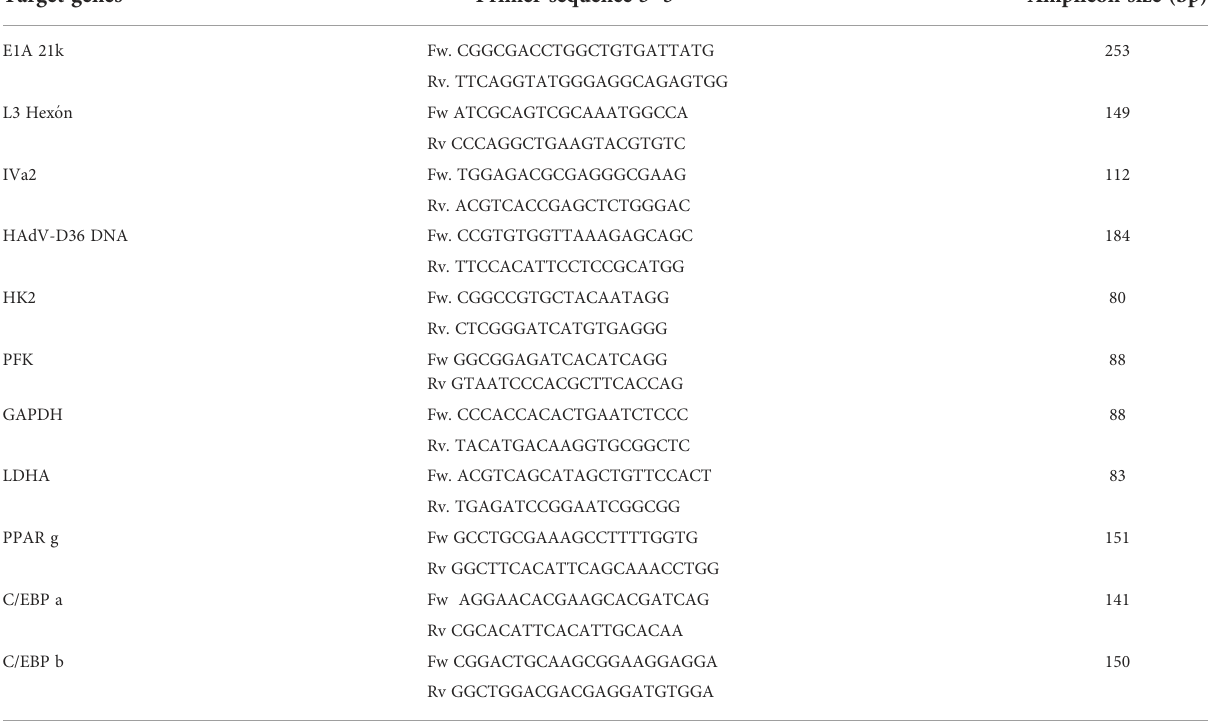
TABLE 1 Primers used for qPCR and